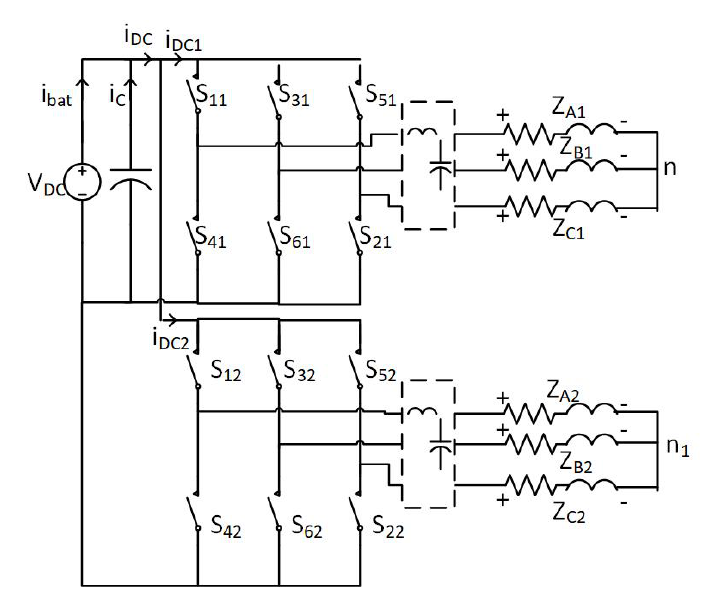
Figure 5. Typical three-phase parallel-connected dual-inverter system. Table 3. Combination of different voltage vectors in SVPWM (sector 1) and their (normalized) DC current